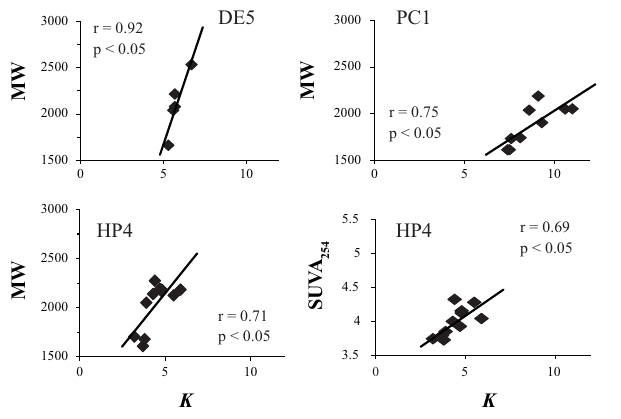
Fig. 7. Correlations between photodegradation rate constant, K (m 2 GJ − 1 ), molecular weight, M W (Da), and SUVA 254 (m − 1 mg − 1 L) in DE5 and PC1 streams during spring and summer